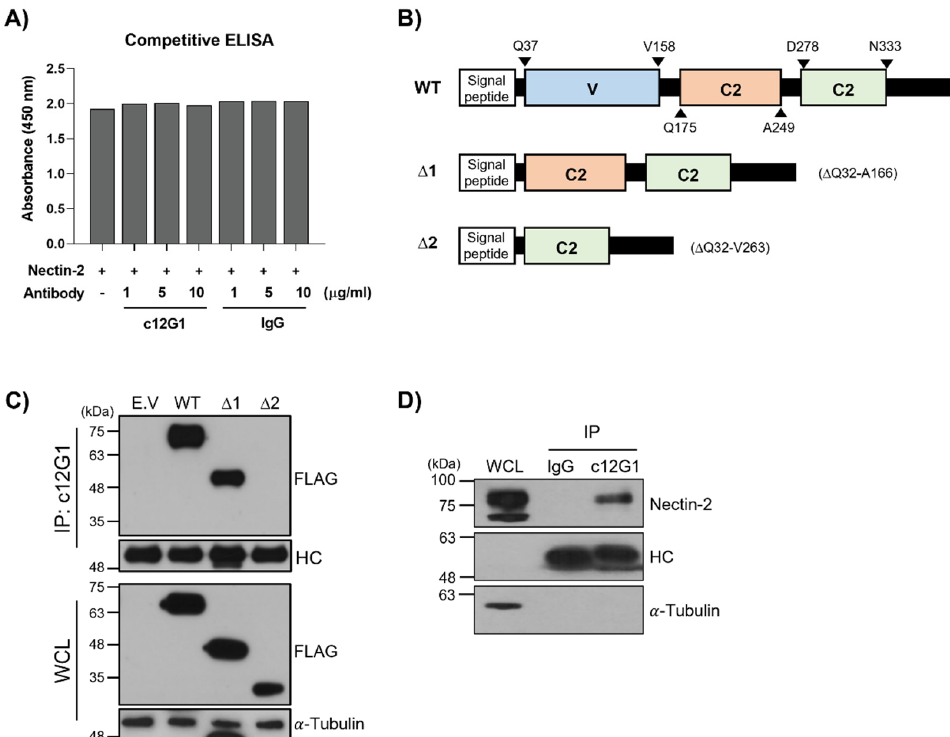
Figure 2. Identification of the nectin-2-binding domain of c12G1. ( A ) PVRIG (100 ng/well) was coated to 96-well plates and the binding of nectin-2 (1 µg/mL) to PVRIG was investigated in the presence of c12G1 antibody, at the indicated concentrations. The results represent mean ± SD of three independent experiments. ( B ) Schematic diagram for the construction of nectin-2 deletion mutants. The extracellular domain of the indicated nectin-2 deletion constructs was cloned into the pCMV6 FLAG vector. ( C ) The wild-type and deletion nectin-2 mutants were transfected into HEK293 cells. The whole cell lysates obtained from these cells were then subjected to immunoprecipitation assay using c12G1 antibody, followed by western blot with an anti-FLAG antibody. ( D ) To determine whether c12G1 antibody can bind to endogenous nectin-2 protein, the whole cell lysates of non-transfected HEK293 cells were subjected to immunoprecipitation assay using the c12G1 antibody or normal human IgG, followed by western blot with an anti-nectin-2 antibody. Ten percent (10 µg) of the cell lysates were loaded as the input control. Tubulin was used as the loading control. All experiments were independently repeated at least three times. HC indicates heavy chain of